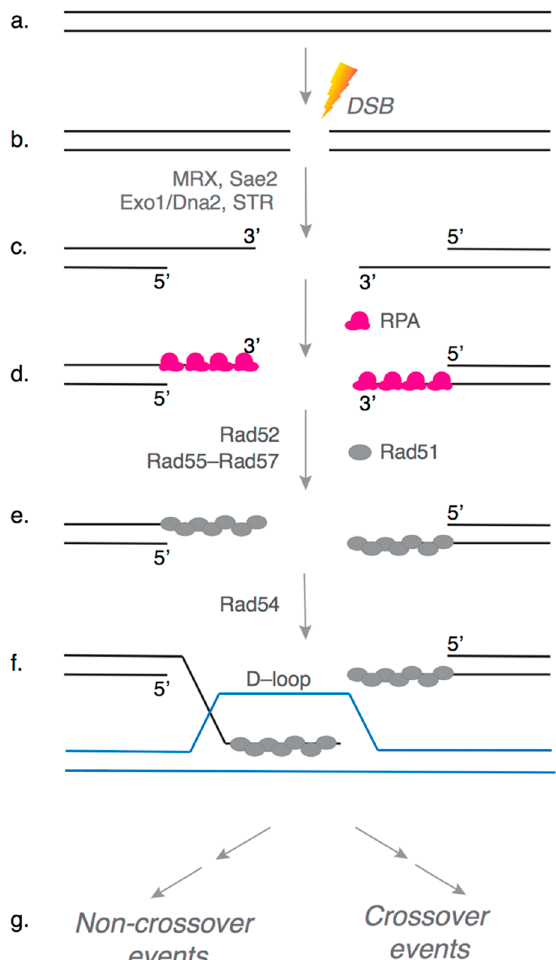
Figure 1. Early steps of Homologous Recombination (HR). A simplified schematic of the early steps of the HR pathway is shown here. ( a , b ) Genomic DNA can be damaged by a variety of agents to generate a double-stranded break (DSB). ( c ) Multiple nucleases resect the DSB ends, generating 3 ′ single-stranded DNA (ssDNA) overhangs, such as Mre11–Rad50–Xrs2 (MRX), Sae2, Exo1, Dna2 and Sgs1–Top3–Rmi1 (STR). ( d ) The overhangs are rapidly bound by the ssDNA binding protein RPA, and ( e ) Rad51 recombinase displaces RPA assisted by mediator proteins Rad52 and Rad55–Rad57 to form the presynaptic complex. ( e ) The presynaptic complex searches the genome for a homologous DNA template with the help of DNA translocase Rad54. ( f ) Rad51 catalyzes DNA strand invasion to form a D-loop intermediate with the homologous template. ( g ) The broken DNA end within the D-loop is extended by DNA polymerases, and the resulting repair intermediate can be resolved via one of several mechanistically distinct pathways (not shown) to produce crossover or non-crossover events.